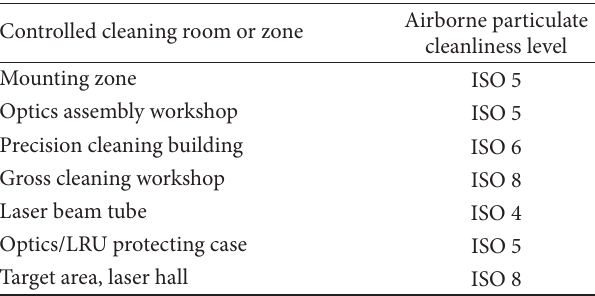
Table 1: Controlling airborne particulate cleanliness in every cleaning room or zone in SG-III laser